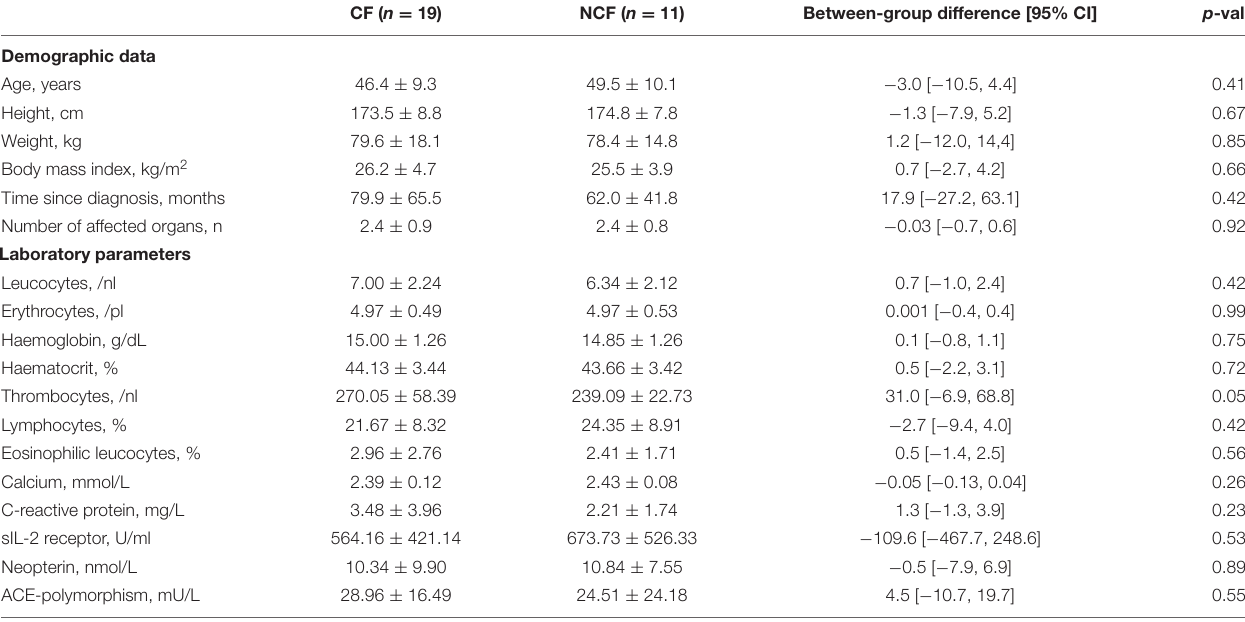
TABLE 1 | Demographic data and laboratory values at baseline for sarcoidosis patients with and without chronic fatigue.